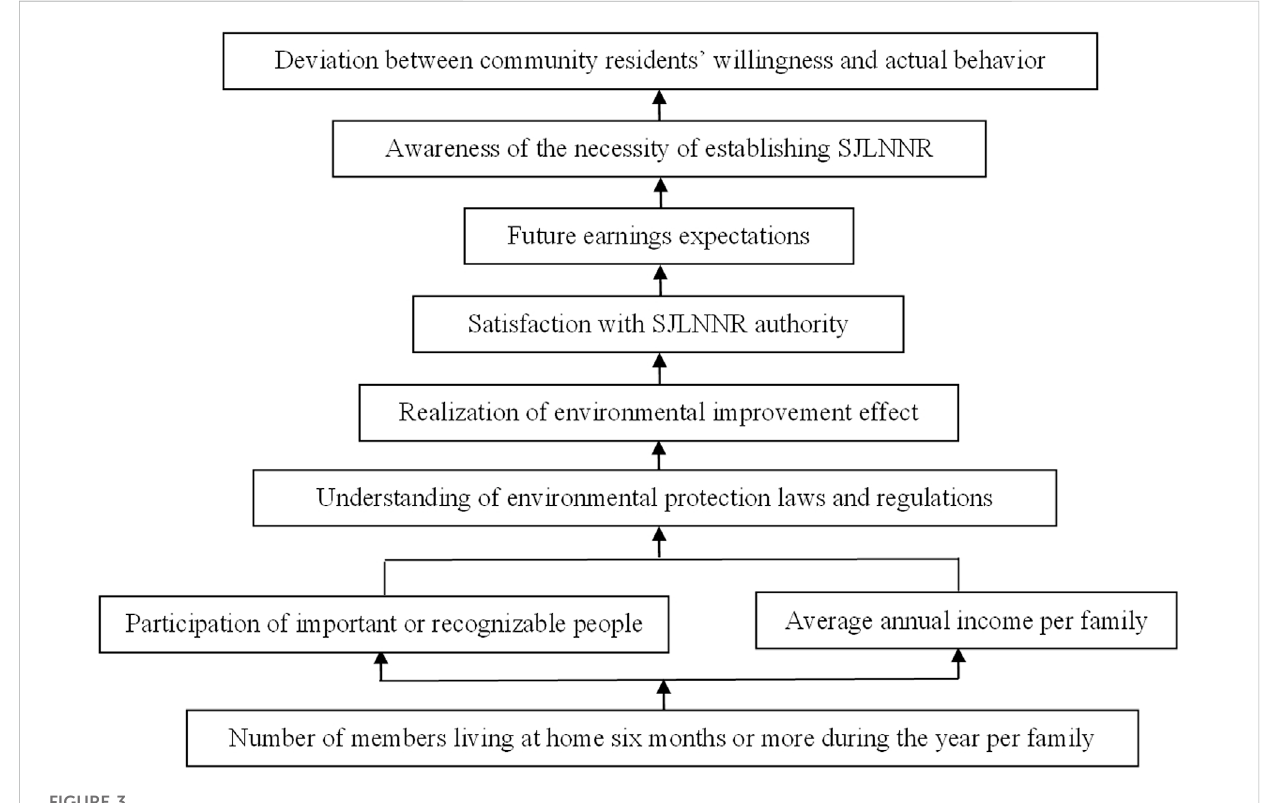
FIGURE 3 The hierarchical structure of the eight in fl uencing